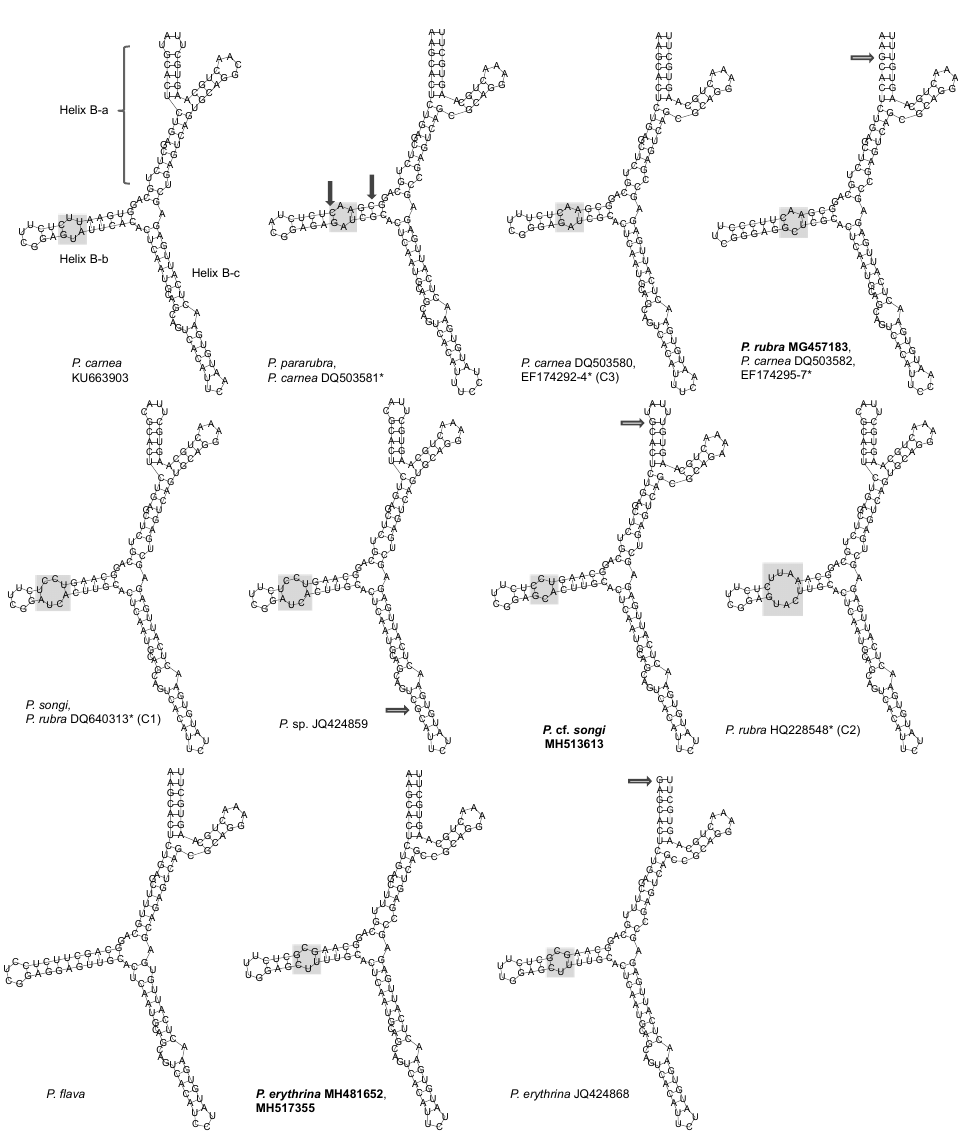
Figure 4. Helix B secondary structures of the Pseudokeronopsis ITS2 molecule. Using the structure of P. carnea as a reference, CBCs are marked with filled arrows and hemi-CBCs are indicated with hollow arrows. Newly sequenced species are in bold. *, misidentified